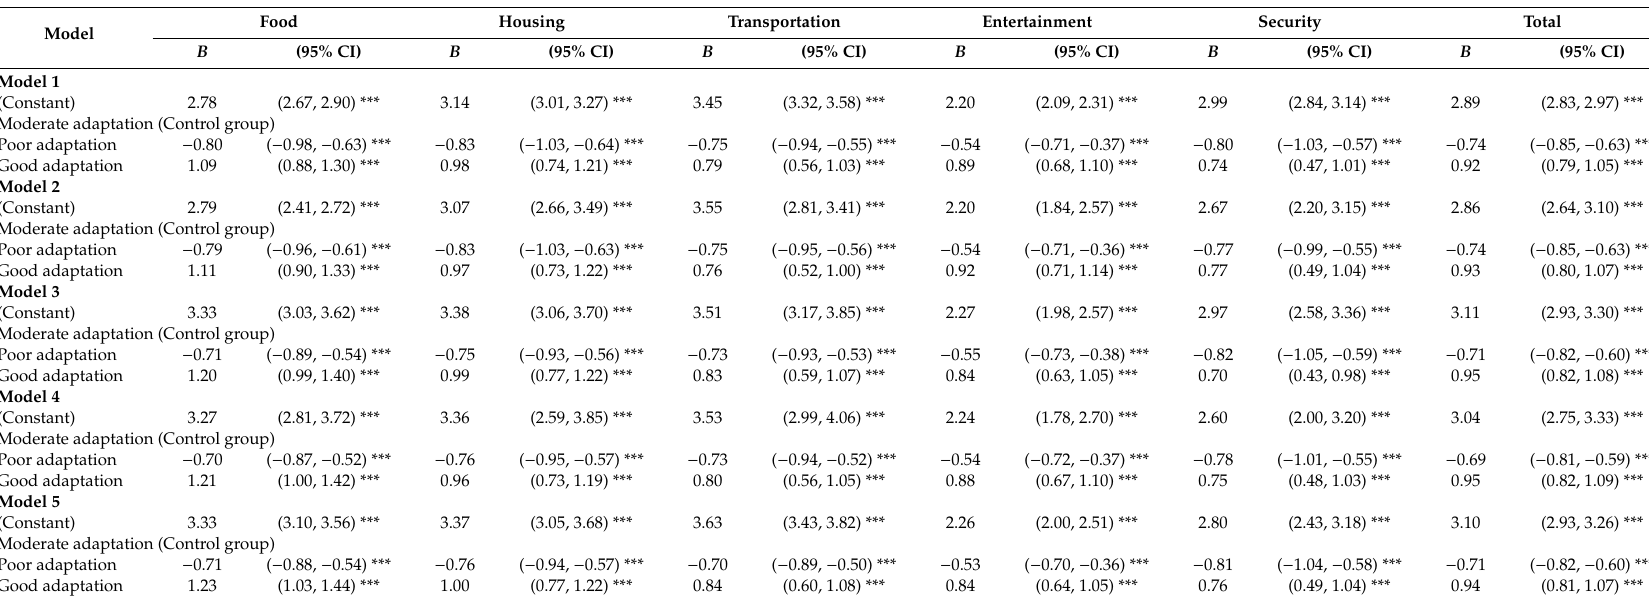
Table 3. Linear regression models testing the association between cross-cultural adaptation and life satisfaction scores. Food Model